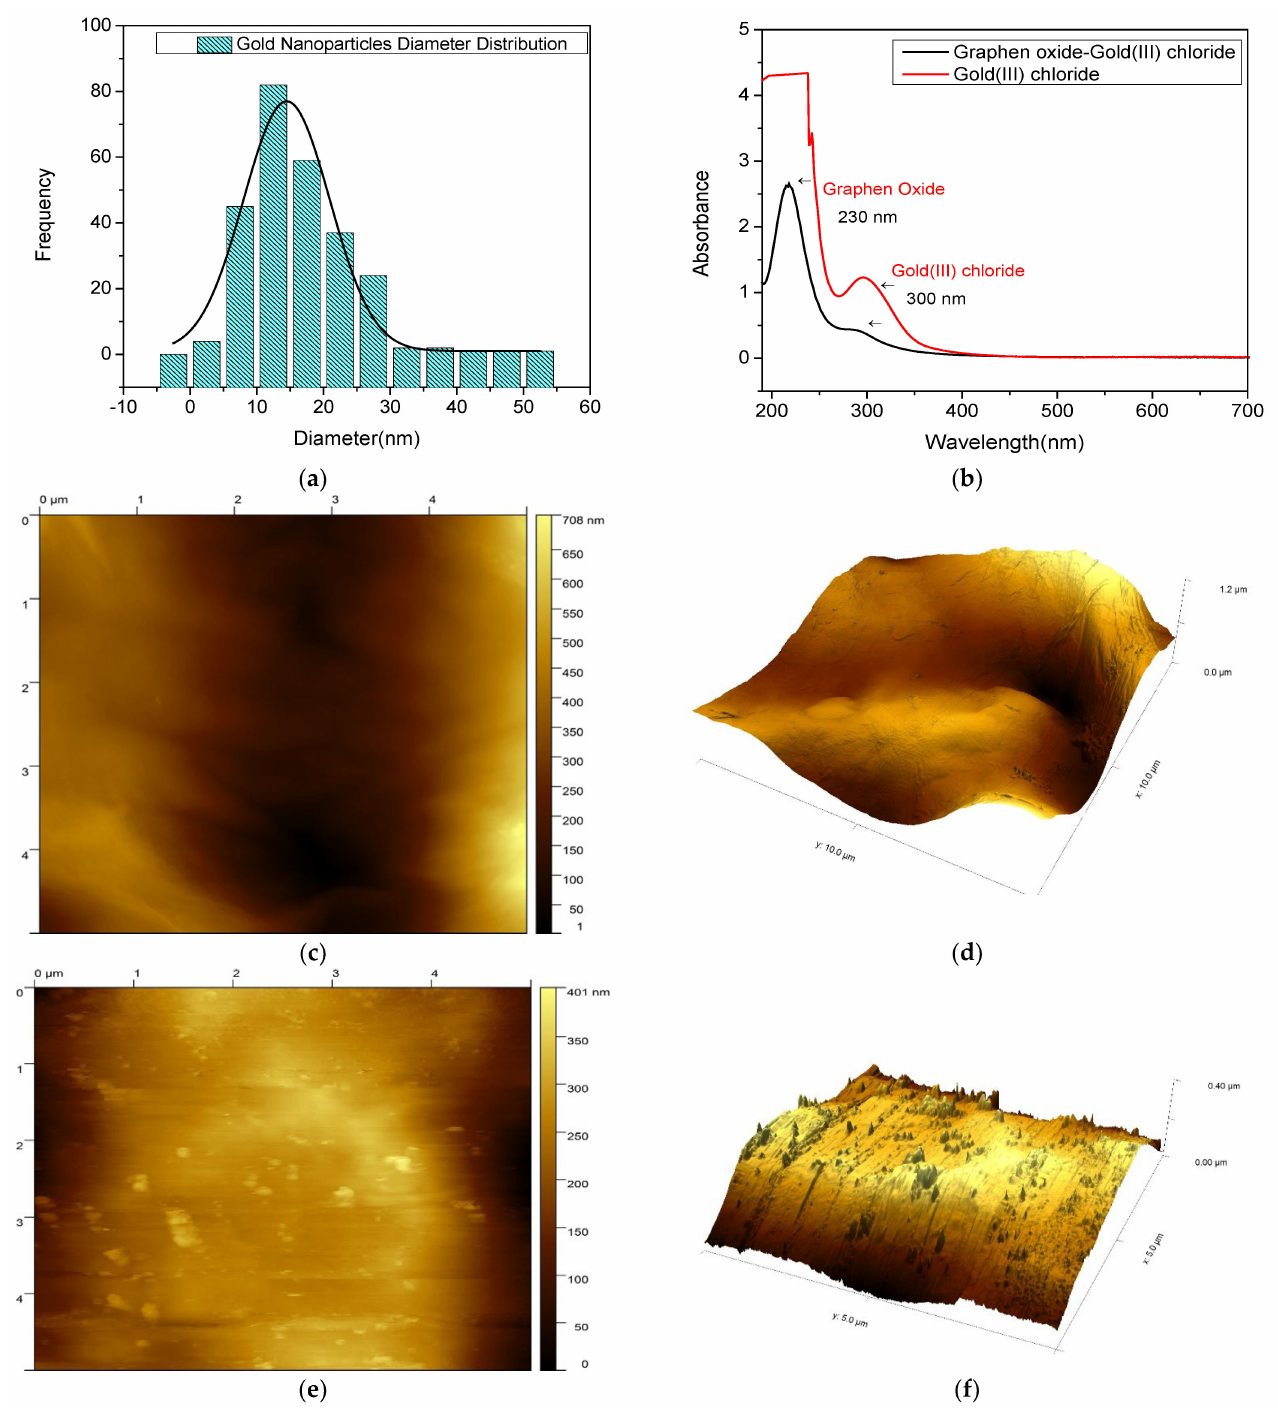
Figure 5. Particle size distribution histogram of gold nanoparticles( a ). UV–vis spectra of graphene oxide and gold (III) chloride( b ). Typical 2D ( c ) and 3D ( d ) AFM images of rGO/NA. Typical 2D ( e ) and 3D ( f ) AFM images of